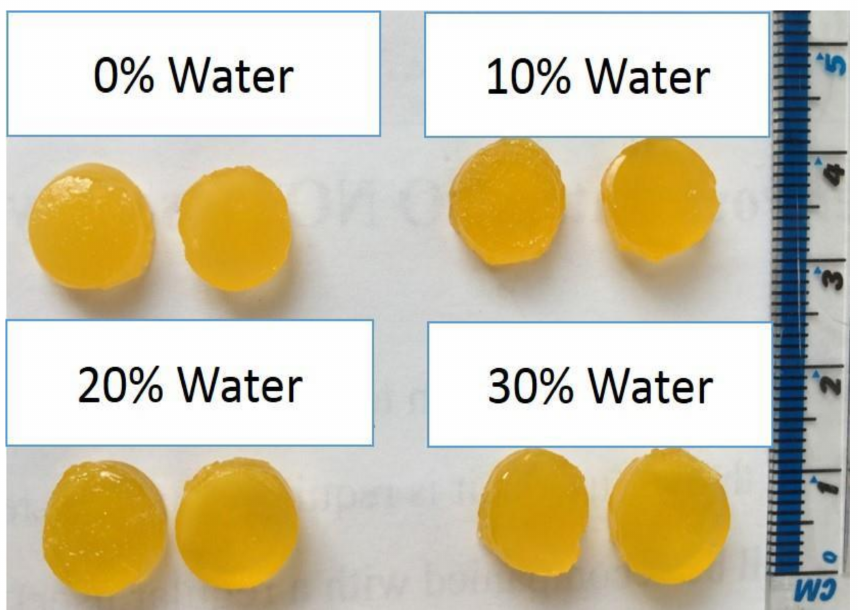
Figure 12. Hydrogels printed with riboflavin/triethanolamine as the photoinitiator with various water contents.